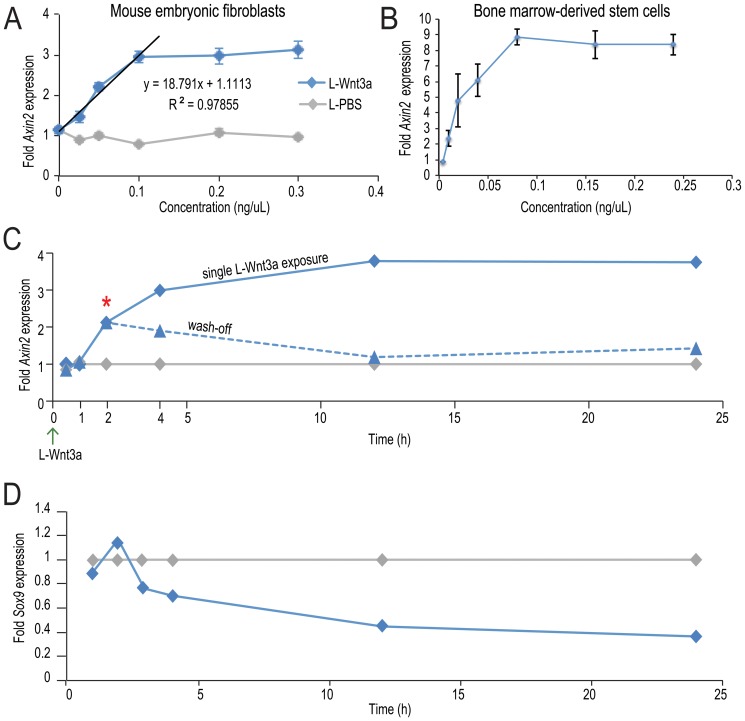
L-Wnt3a activates Wnt/beta-catenin pathway responses in a variety of cell types.Quantitative RT-PCR analyses demonstrate that in (A) primary mouse embryonic fibroblasts and (B) BM-derived mesenchymal stem cells, Axin2 expression shows a dose-dependent increase in response to increasing L-Wnt3a concentrations. (C) MEFs were incubated with L-PBS (grey line) or L-Wnt3a for varying amounts of time. After 2 h, L-Wnt3a induces Axin2 expression, just above baseline. After 4 h, L-Wnt3a induced Axin2 expression has increased 3-fold (blue line). Following a 2 h-incubation with L-Wnt3a the media is removed and incubation continues for varying amounts of time (dashed blue line). 2 h after wash off, Axin2 expression starts steadily declining and returns to baseline at 12 h. (D) MEFs were incubated with vehicle (grey line) or L-Wnt3a (blue line) for up to 24 h. After 3 h, L-Wnt3a represses Sox9 expression and keeps it repressed through 24 h of incubation.